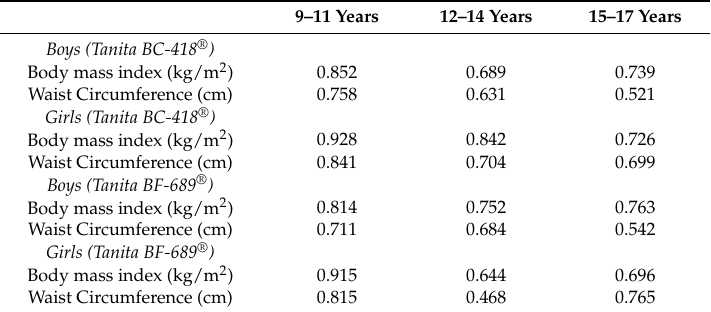
Table 2. Adjusted correlations between percentage of body fat (Tanita BF-689 ® and Tanita BC-418 ® ), body mass index, and waist circumference by sex and